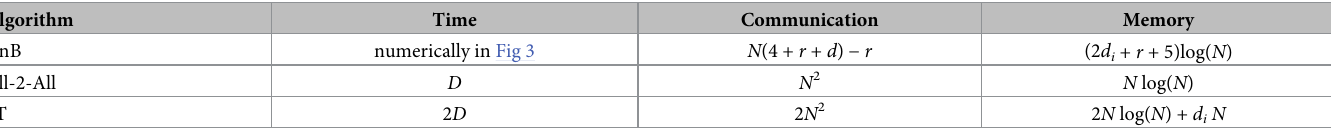
Table 2. Exact costs for the two algorithms for a general network with diameter D , average degree d , and r residue nodes. For memory cost, we indicate the individual degree d i for the generic node i . The AnB algorithm is more efficient than the All-2-All and the ST methods in terms of memory and communication. Analytical solution for time is out of reach and we provide numerical results in Fig 3. Algorithm